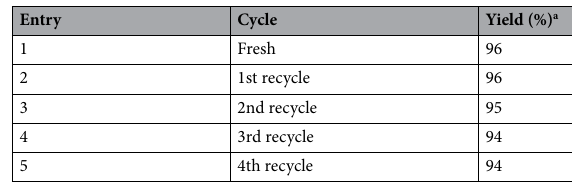
Table 4. Reusability of HMTA-BAIL@MIL-101(Cr). Reaction conditions: 4-bromobenzaldehyde (1 mmol), 1 H -tetrazole-5-amine (1 mmol), and 3-cyanoacetyl indole (1 mmol), HMTA-BAIL@MIL-101(Cr) (0.01 g), solvent-free, 100 °C, 15 min. a Isolated